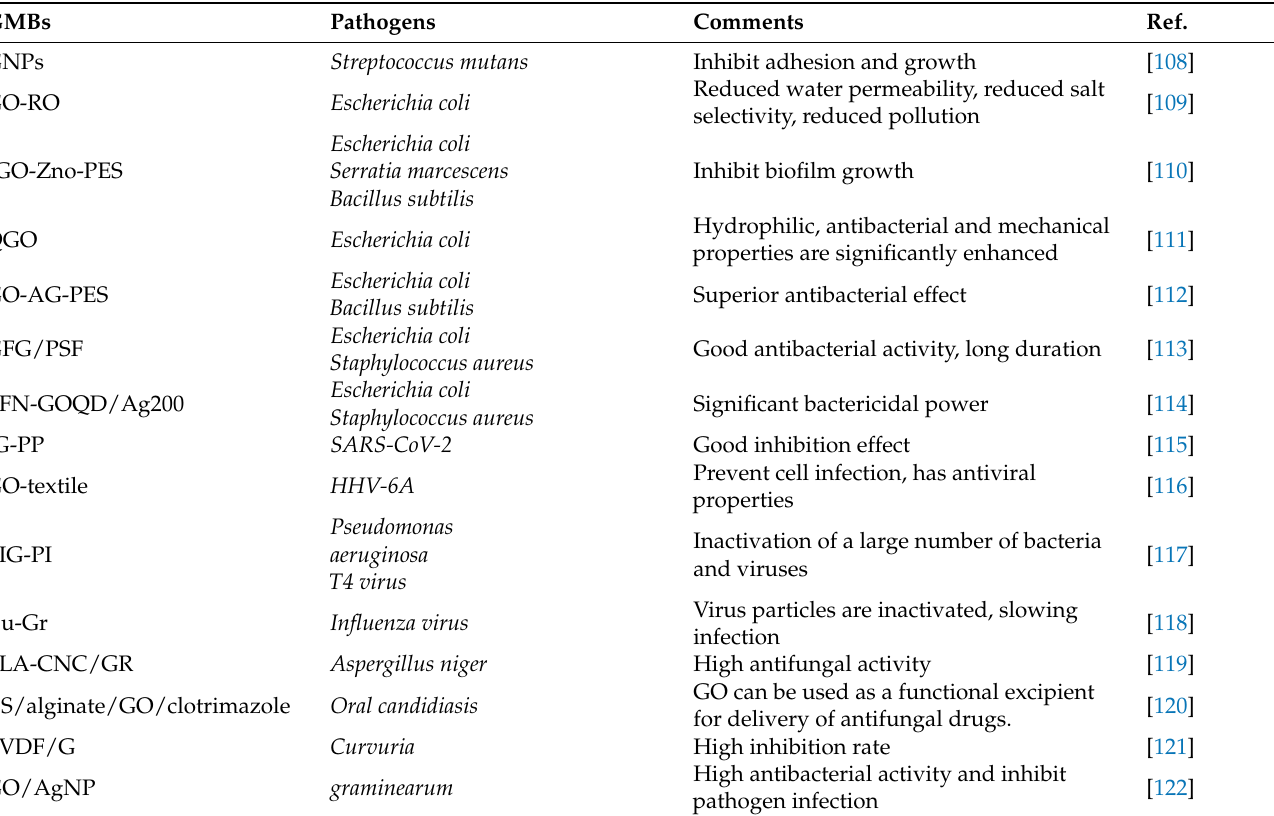
Table 1. Antimicrobial materials, activity, and application of graphene-based membranes.